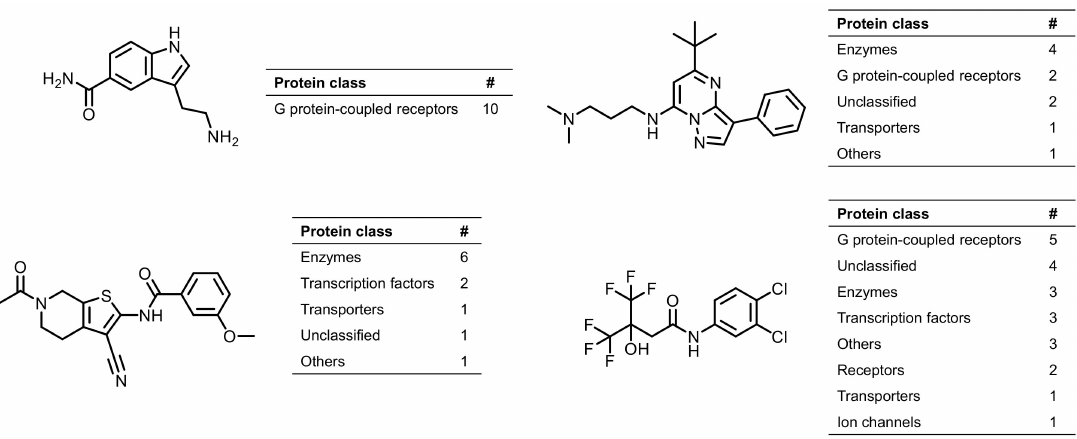
Figure 3. Shown are examples of multitarget ligands. For each compound, the number of targets from di ff erent classes is reported. The first ligand is exclusively active against proteins of the G protein-coupled receptor class (single class ligand), whereas the other ligands exhibited activities against targets from di ff erent classes (multiclass